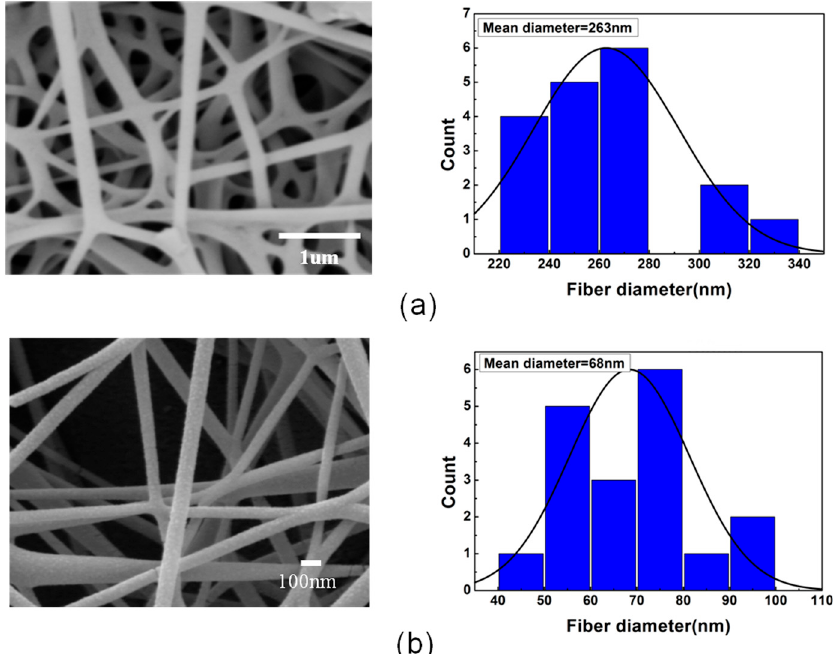
Figure 2. SEM images of PVA/PEDOT:PSS fabricated under ( a ) traditional electrospinning (20 kV), ( b ) high pressure airflow assisted electrospinning (70 kV), and the fiber diameter distribution table of each group of fibers is shown on the right.